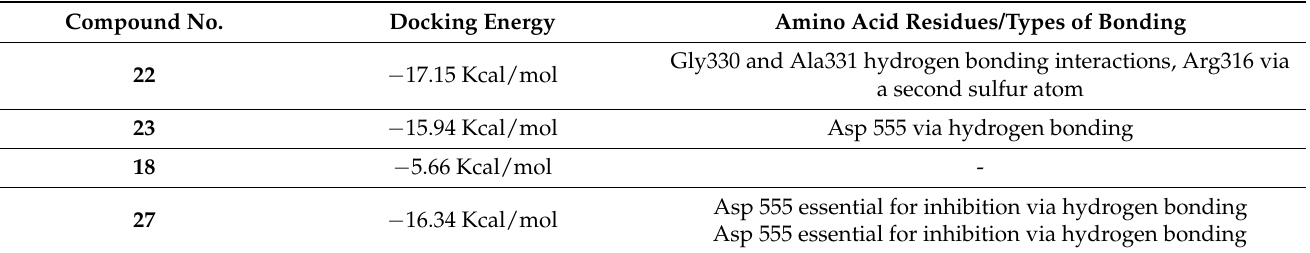
Table 6. Docking energies and binding of selected compounds.